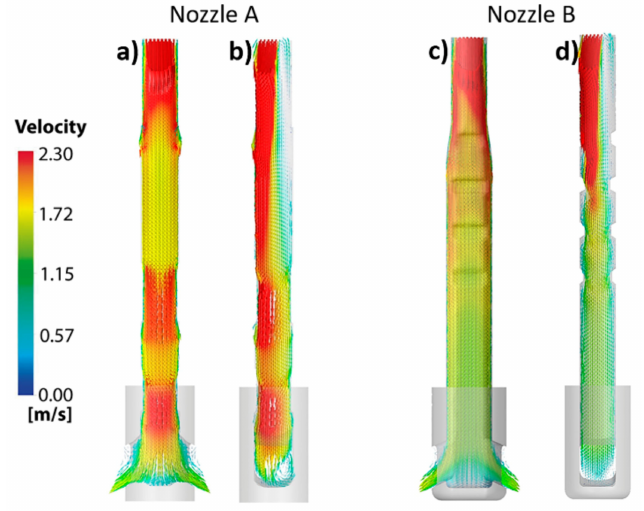
Figure 14. Numerical velocity fields in the nozzles without clogging. ( a ) Longitudinal plane axis of symmetry of nozzle A. ( b ) Longitudinal plane axis of symmetry of nozzle A at 90 ◦ . ( c ) Longitudinal plane axis of symmetry of nozzle B. ( d ) Longitudinal plane axis of symmetry of nozzle B at 90 ◦ .